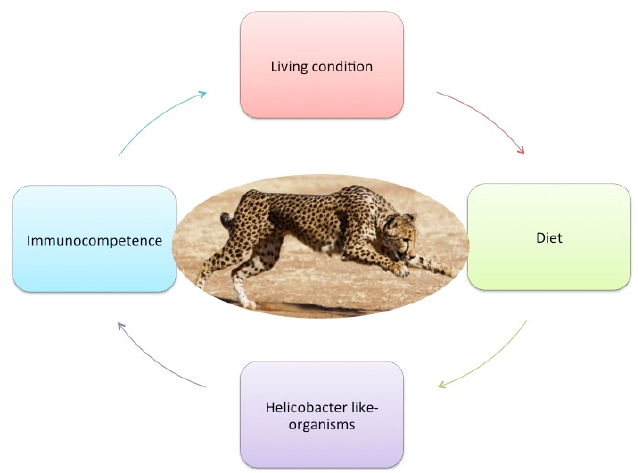
Figure 1. Factors implicated in the pathogenesis of chronic gastrointestinal disorder in cheetah. These factors may cause more evident clinical manifestations and aggravate the